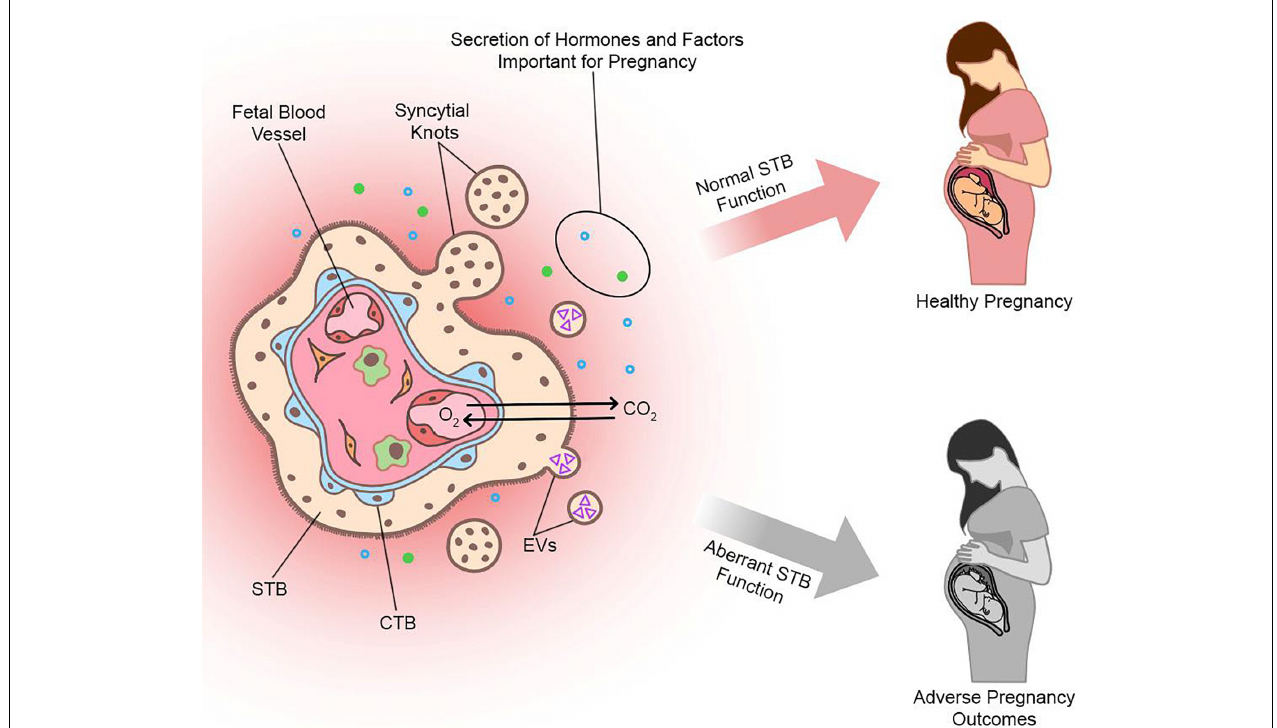
FIGURE 3 | Schematic illustrating the multifunctional importance of STB for healthy pregnancy. A cross section of a chorionic villus near term is shown. O 2 , micronutrients, immunoglobulins, water, and various other substances pass across the STB layer to gain access to blood vessels in the villus core, through which they can be carried to the fetus. CO 2 and waste products diffuse across the STB layer from fetal to maternal blood. STB also produces and secretes a variety of factors into maternal blood, including peptide and steroid hormones, growth factors, EVs, and larger vesicles (e.g., syncytial knots). Given the diverse functions of STB for pregnancy success and its contiguity with maternal blood, aberrant STB function can contribute to adverse pregnancy outcomes.